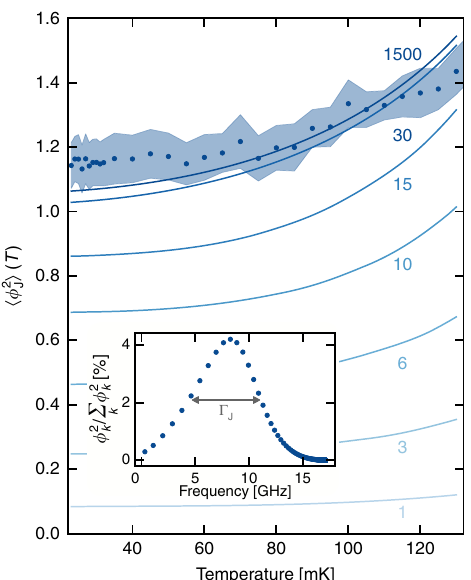
Fig. 4 Many-body nature of the ZPF. Total phase fl uctuations across the small Josephson junction in sample B, taking into account in our model (full lines) different numbers of modes of the environment, ranging from one (light blue) to the total number (dark blue). The inset shows the relative contribution of the different modes to the total fl uctuations, with Γ the FWHM of this